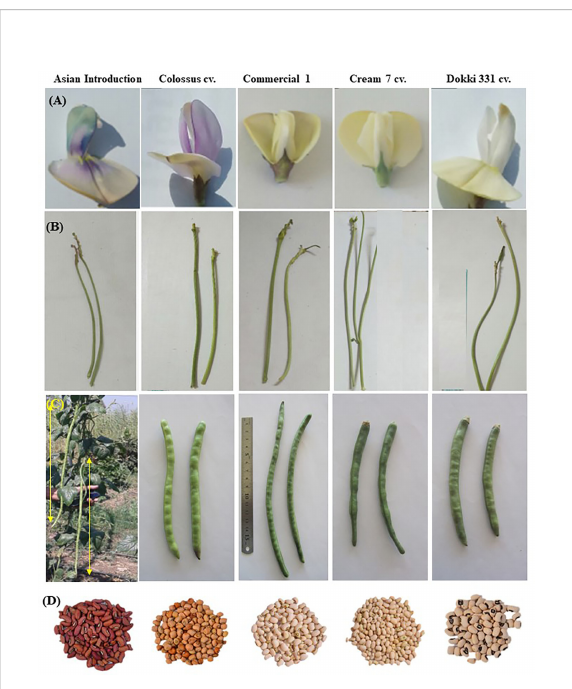
FIGURE 1 (A) fl ower traits, (B) peduncle length, (C) pod traits and (D)